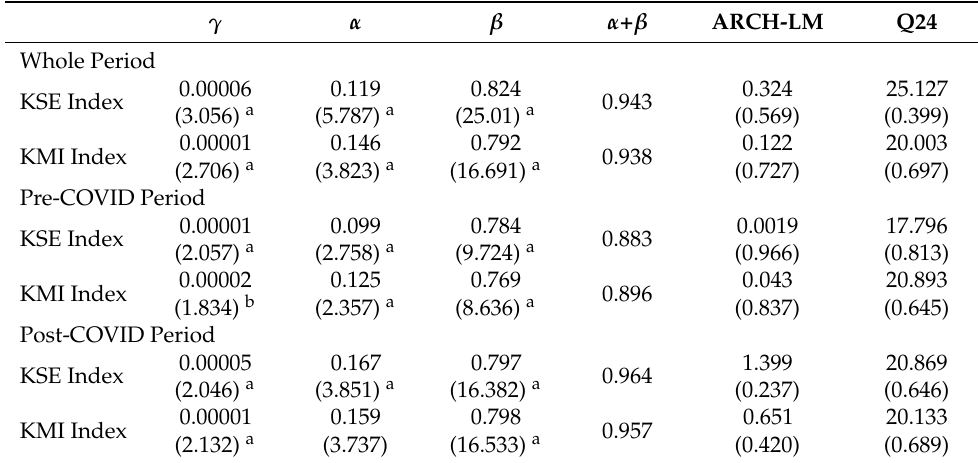
Table 3. GARCH (1,1)